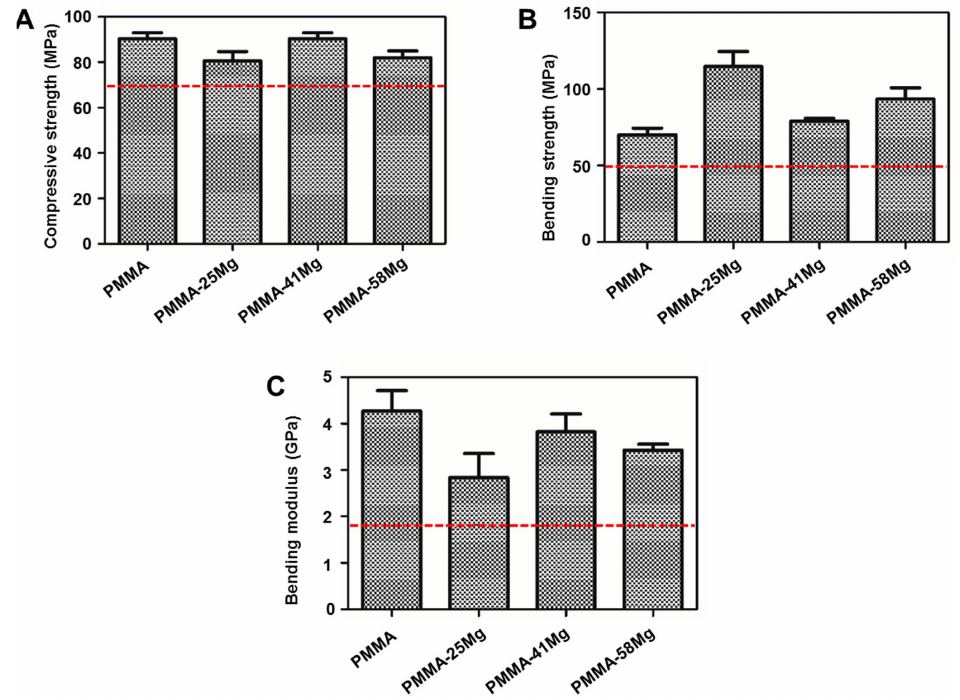
Figure 4. The mechanical properties of PMMA–Mg composite bone cement. ( A ) Compressive strength; ( B ) bending strength and ( C ) bending modulus. Red dashed line shows the ISO 5833 industry